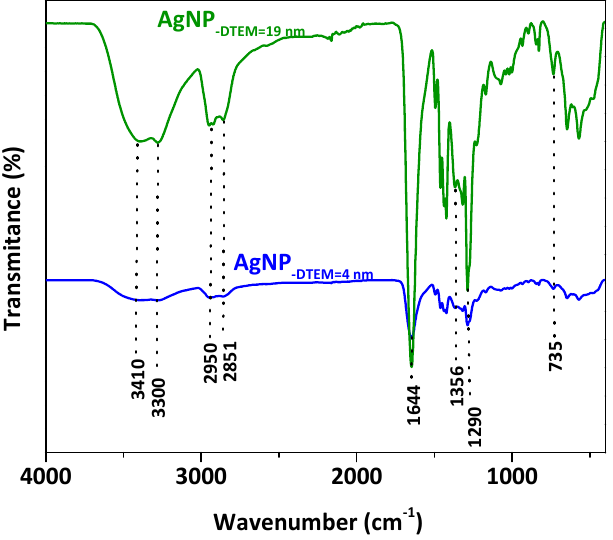
Figure 3. Fourier-transform infrared spectroscopy (FTIR) spectra of synthesized, PEI-coated, PVP- stabilized AgNP with average diameters of 19 nm (green) and 4 nm (blue), with the characteristic bands as evidence.